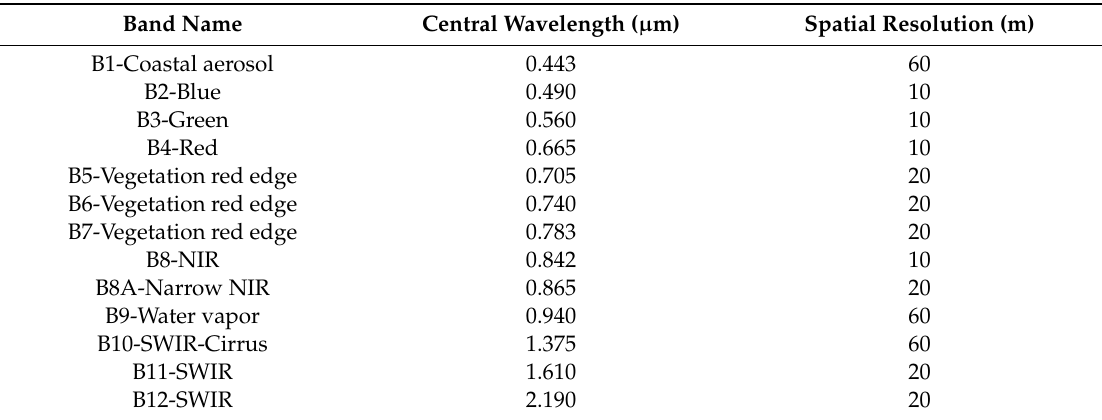
Table 1. Sentinel-2A MSI spectral band